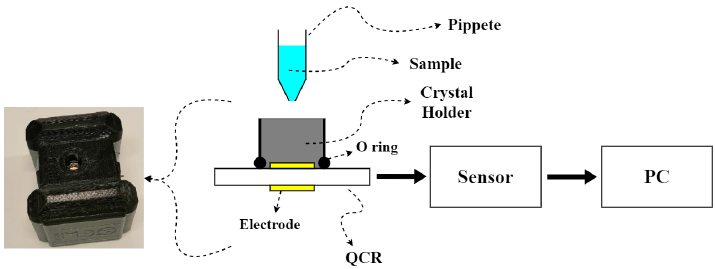
Figure 2. Experimental set up. The sample is poured onto the